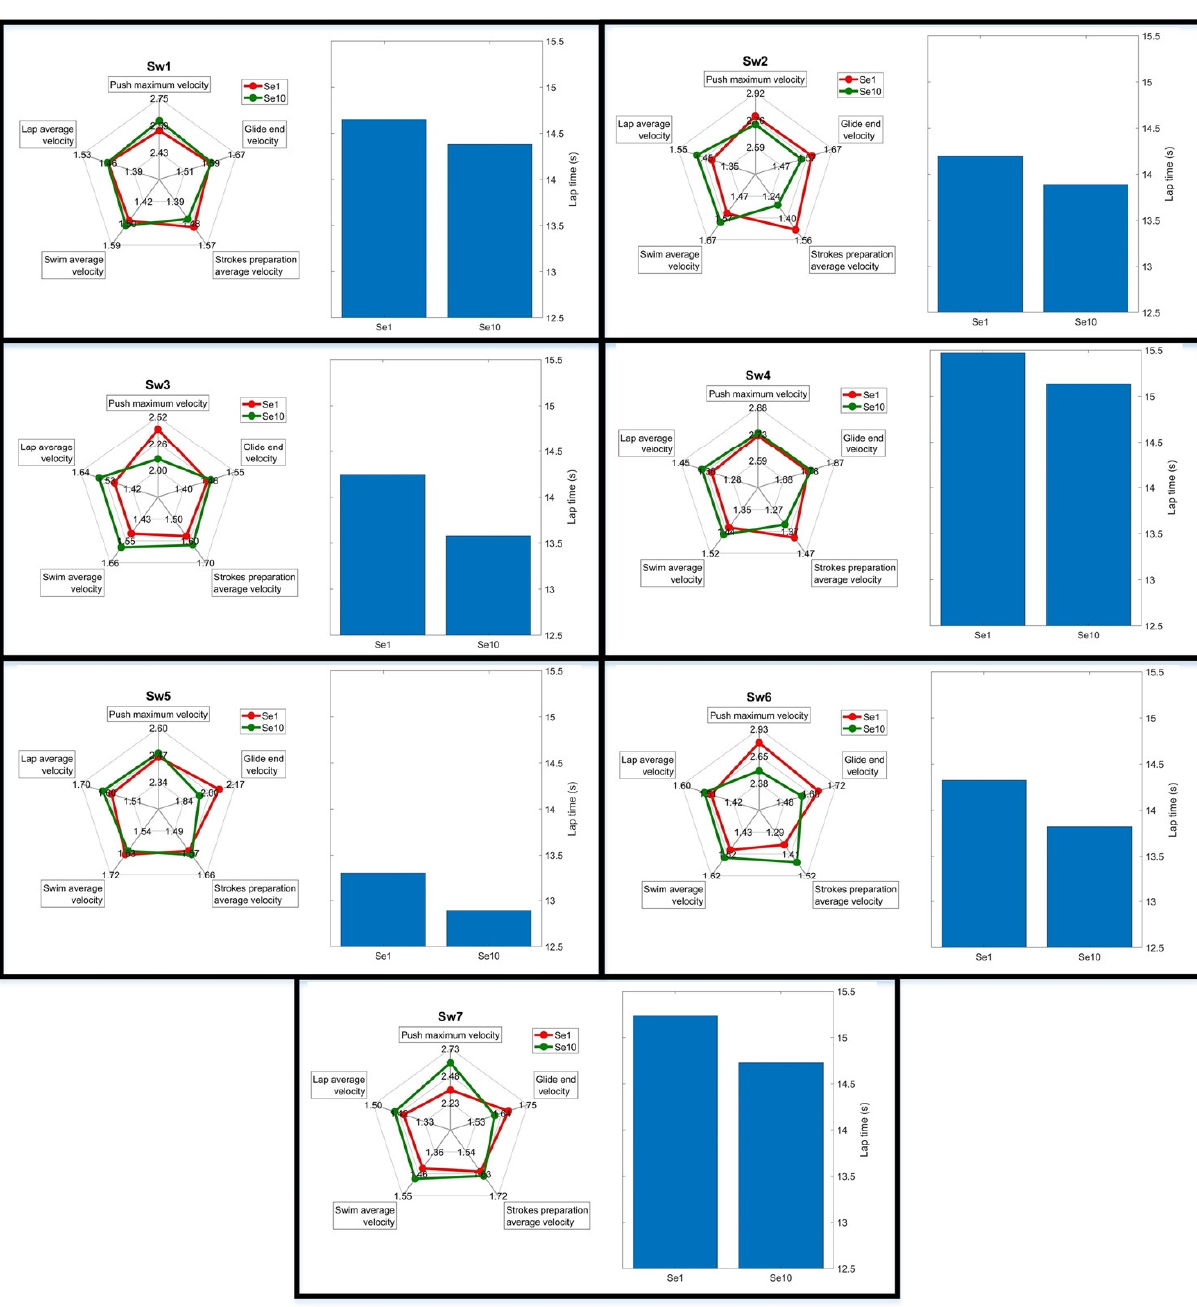
Figure A2. Average values of goal metrics and lap times in first (Se1) and last (Se10) session for the swimmers of the control group.